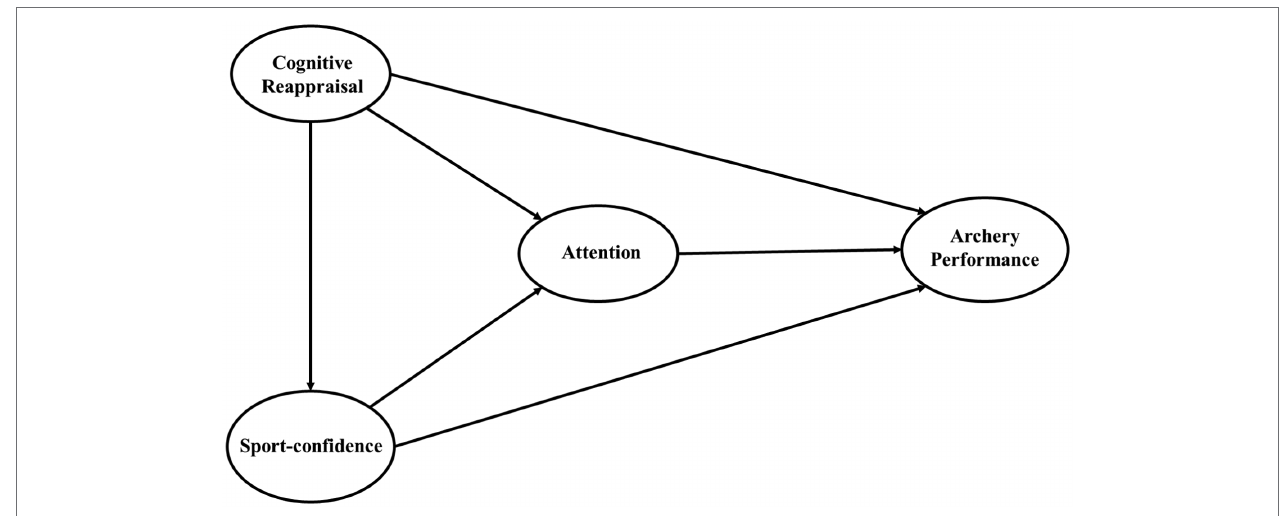
FIGURE 1 | Structural